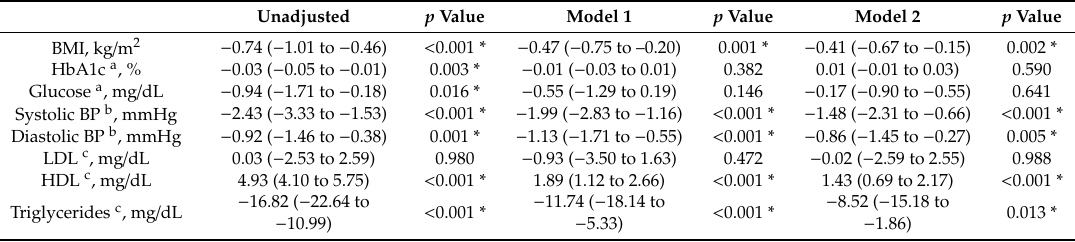
Table 3. Variation of cardiometabolic parameters in participants exposed to probiotics compared to non-exposed participants. Unadjusted p Value Model 1 p